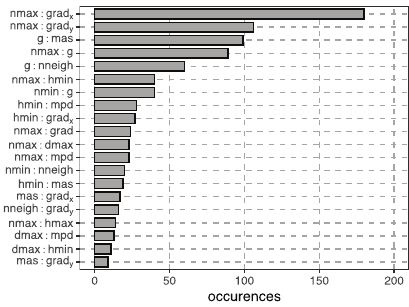
Figure 10. Distribution of the best two-parameter model coef fi cients of determination resulting from the 1000 cross- validated grid search runs.